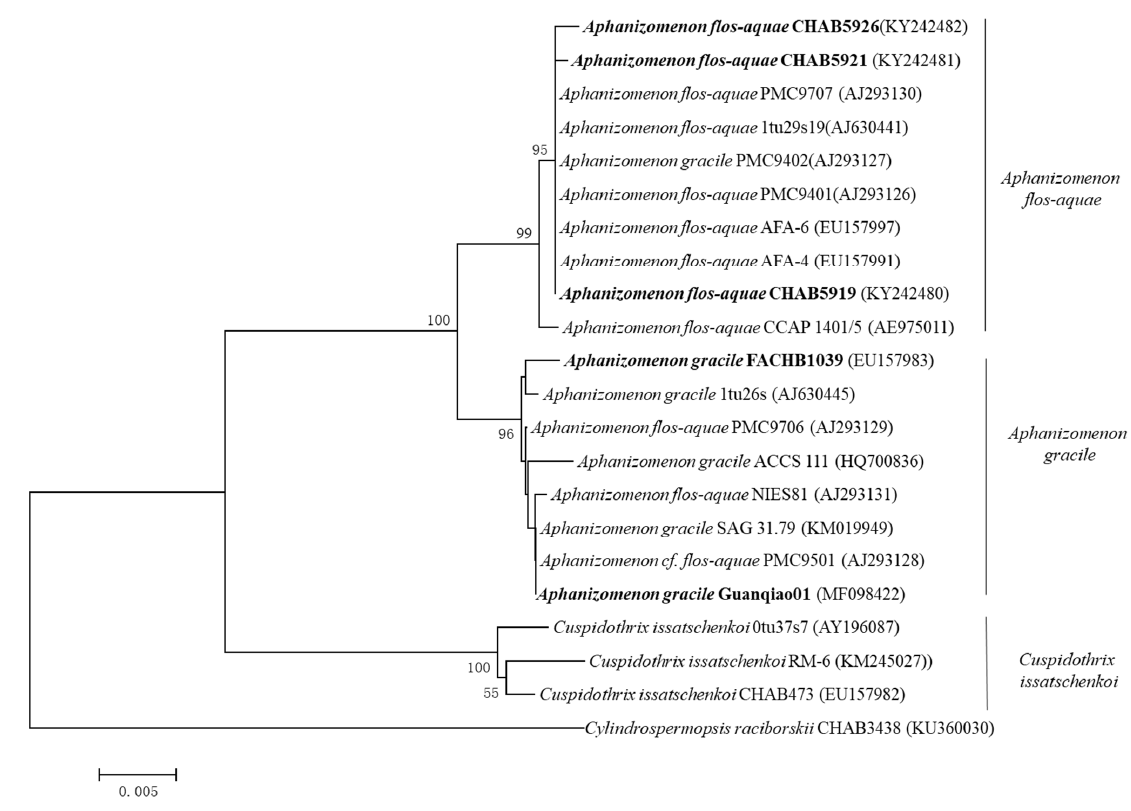
Figure 2. Phylogenetic analysis of the 16S rRNA gene sequences of Aphanizomenon strains used in this study. GenBank accession numbers were presented in the parenthesis.